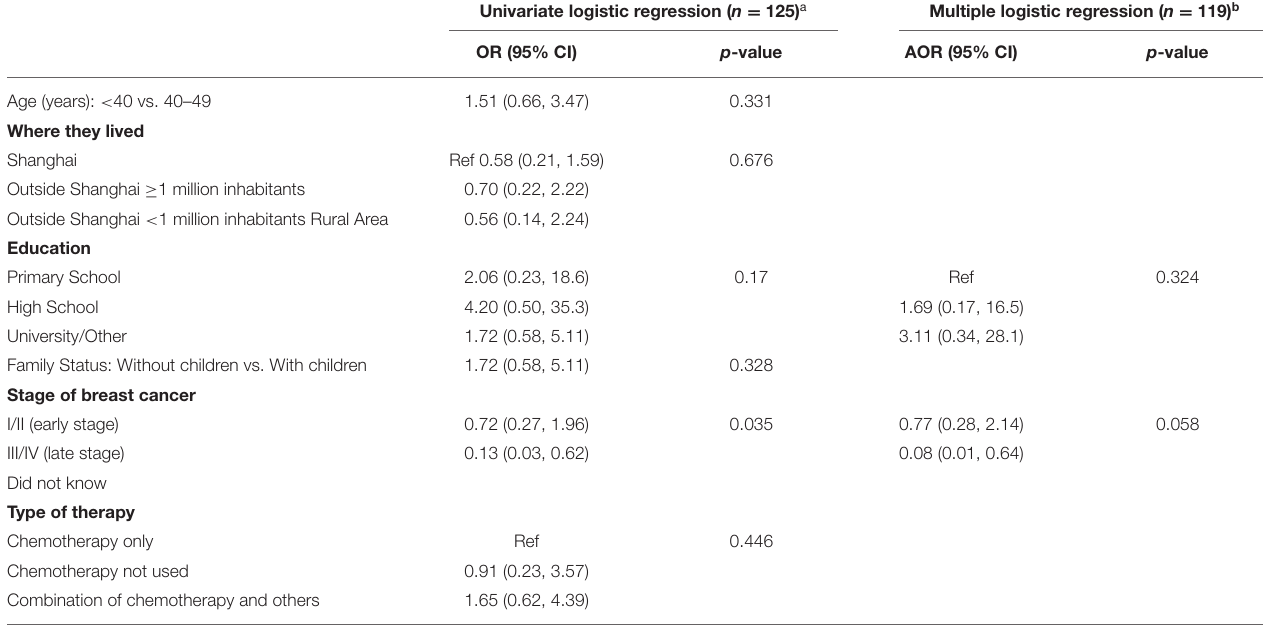
TABLE 7 | Factors associated with knowing “what oncofertility was” among breast cancer patients ( n = 125). Univariate logistic regression ( n = 125) a Multiple logistic regression ( n = 119)